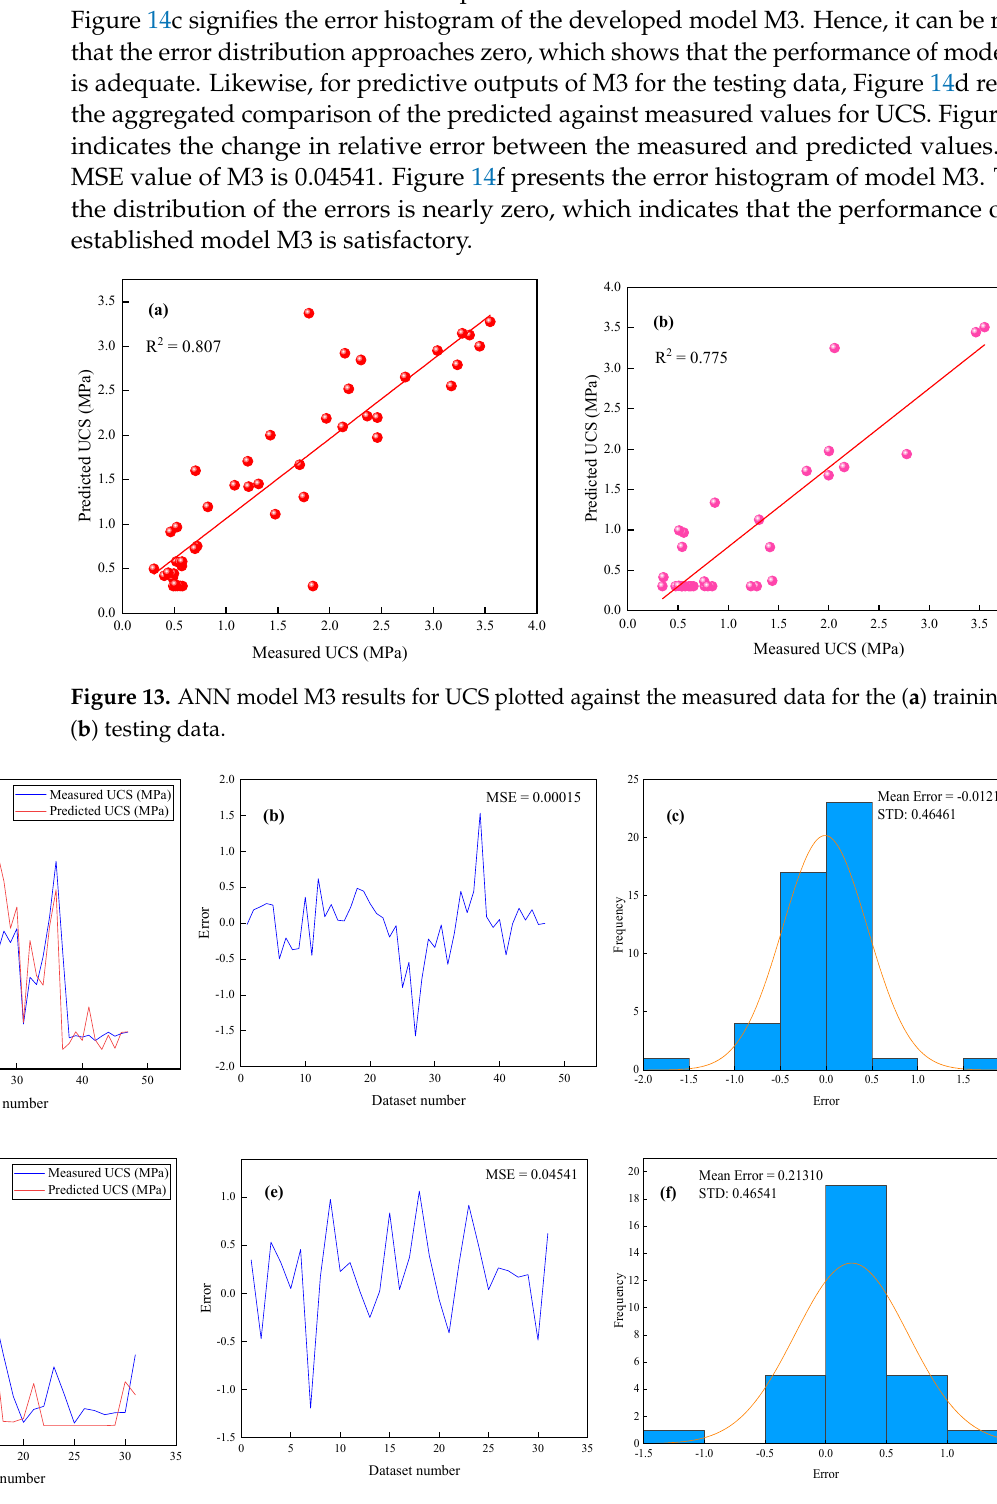
Figure 14. The demonstration of ANN model M3 for UCS. ( a ) Model M3 results aggregated with the measured UCS. ( b ) The variation in error between the measured and predicted values. ( c ) Error histogram for the training data and ( d ) model M3 results aggregated with the measured data. ( e ) The variation in error between the measured and predicted values. ( f ) Error histogram for the testing data.